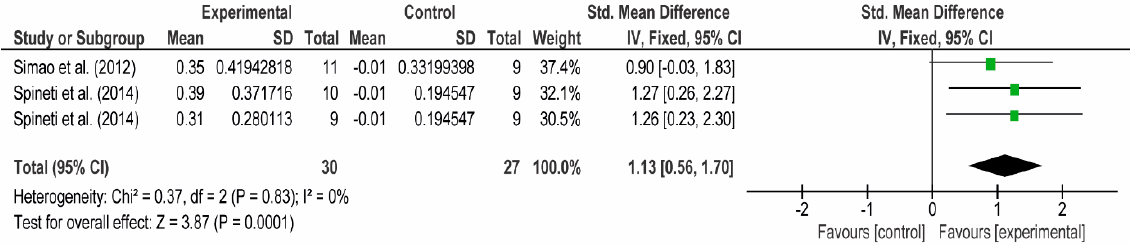
Figure 18. The effect size of 12 -weeks of linear periodised resistance training on increasing the bi- ceps brachii MT. The lines for Spineti et al. [90] respectively represent linear periodised large to small muscle training and small to large muscle training groups.